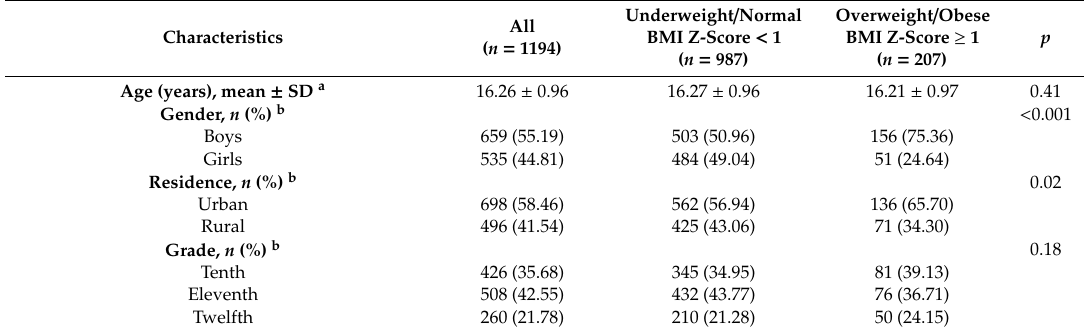
Table 1. Baseline characteristics of participants by weight